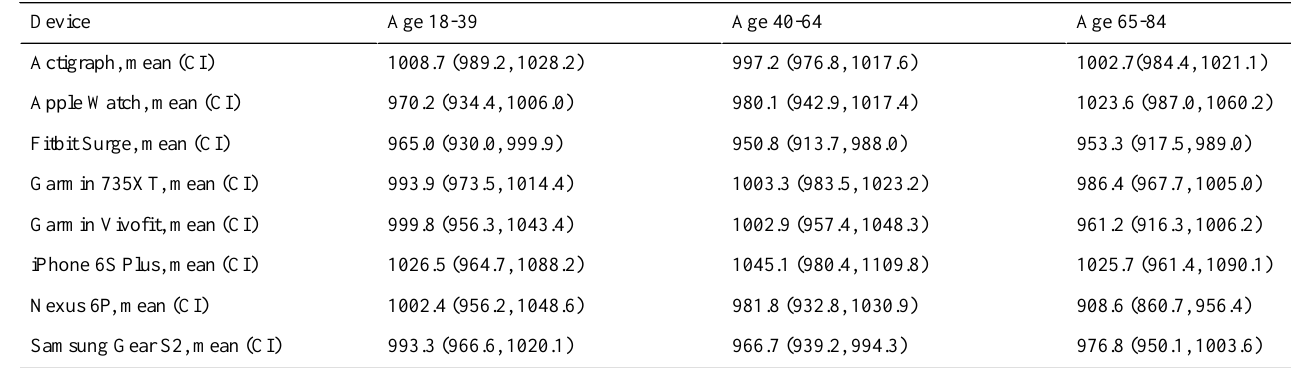
Table 4. Predicted means of steps for each device by age (adjusted for BMI, dominant hand, and